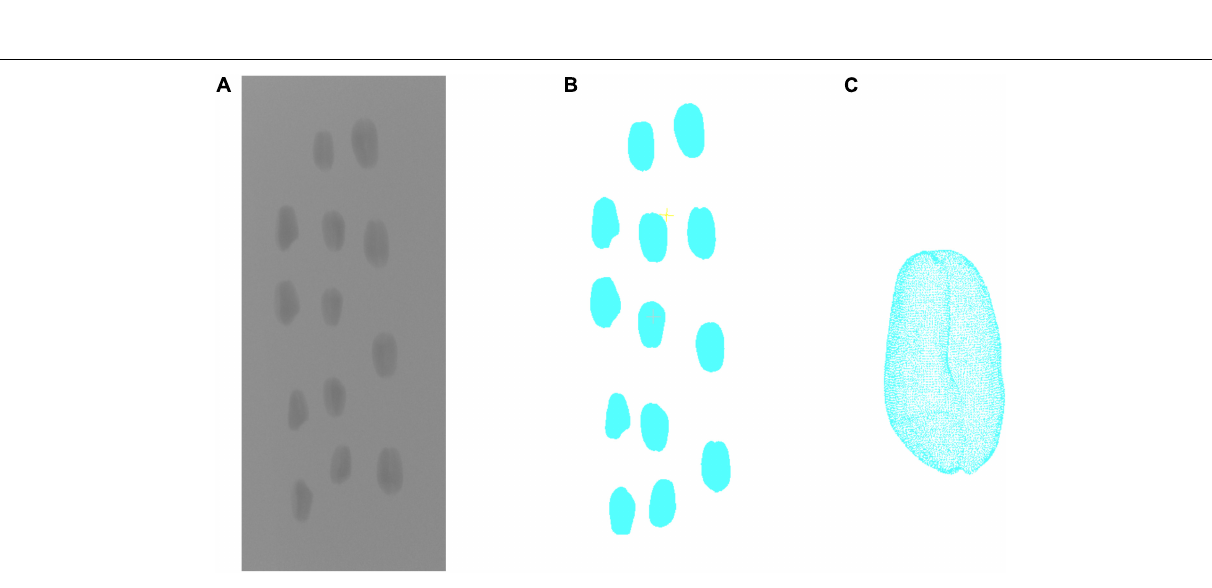
Frontiers in Plant Science |